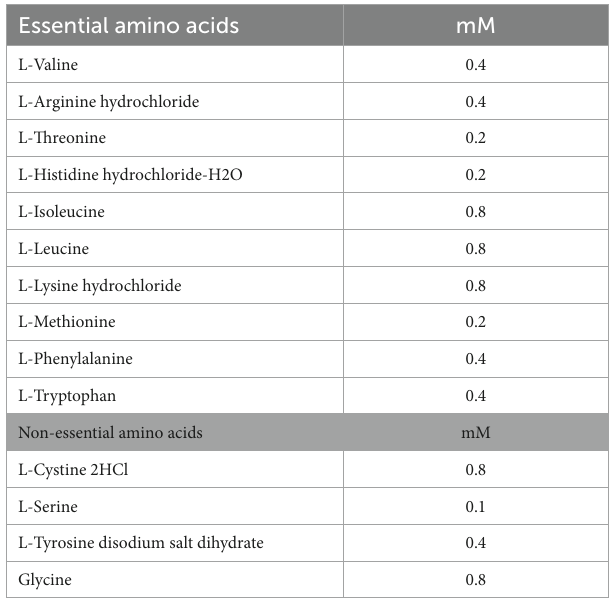
TABLE 1 The concentration of amino acids in DMEM